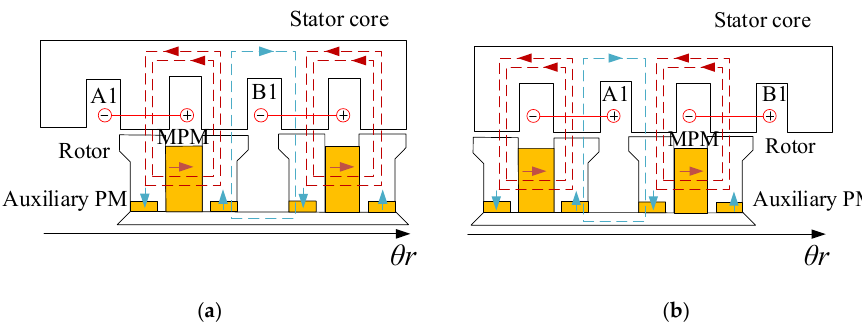
( b ) Figure 3. Phase coupling of the fault-tolerant PM motor. ( a ) Single-phase excitation magnetic field lines. ( b ) Self-inductance and mutual-inductance between phases. 3. Analysis of Loss under Inter-Turn SC Inter-turn SC fault is a very complex fault. Since the insulation layer between SC turns is not completely destroyed at the beginning, there is a contact resistance that makes the SC current smaller between the SC turns. The degree of inter-turn SC fault deepens as the temperature of SC turns increases, and it eventually becomes complete SC. Addition- ally, at this time, the insulation layer between SC turns is completely destroyed and the